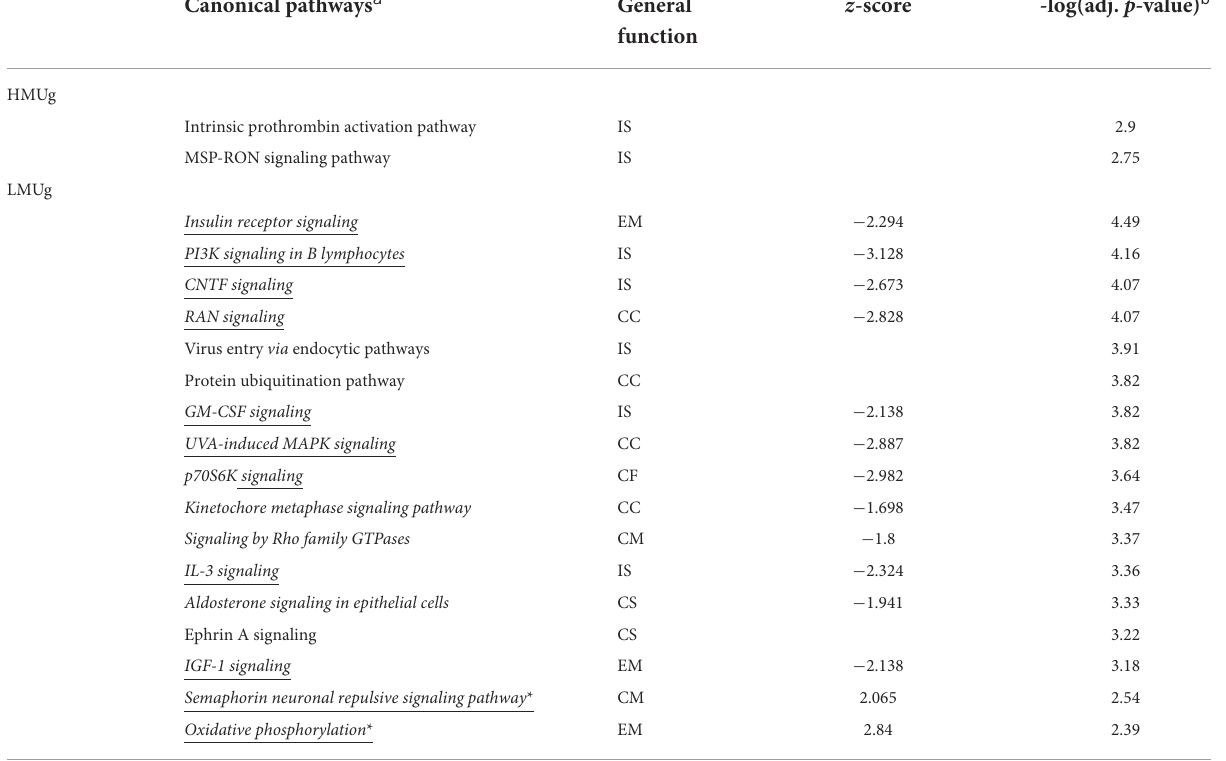
z -score -log(adj. p -value) b function